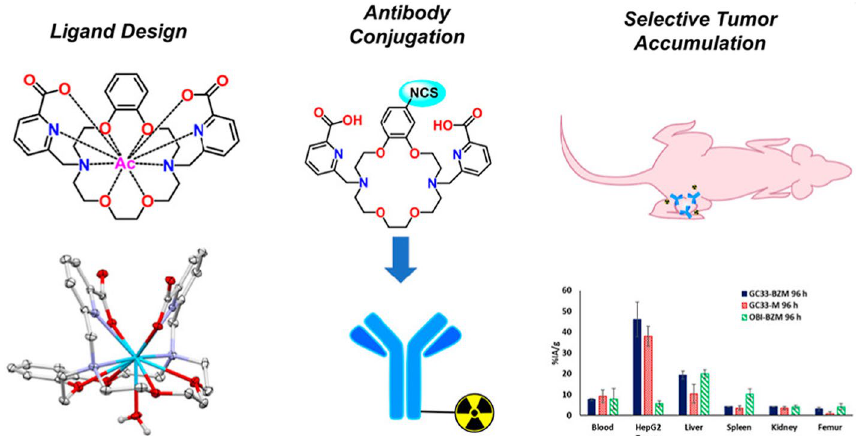
Fig. 3 Overview of use of new H2BZmacropa chelator, its conjugation to an antibody and biodistribution results. (from Bioconjugate Chem. 2022;33, 6,